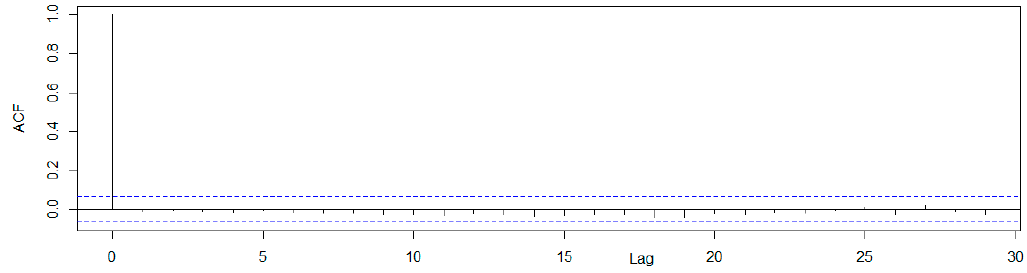
Figure 12. Autoregressive (AR) (4) residual model (own elaboration). Artificial neural networks (ARNNs) (p, P, k) m: Autoregressive neural networks C.